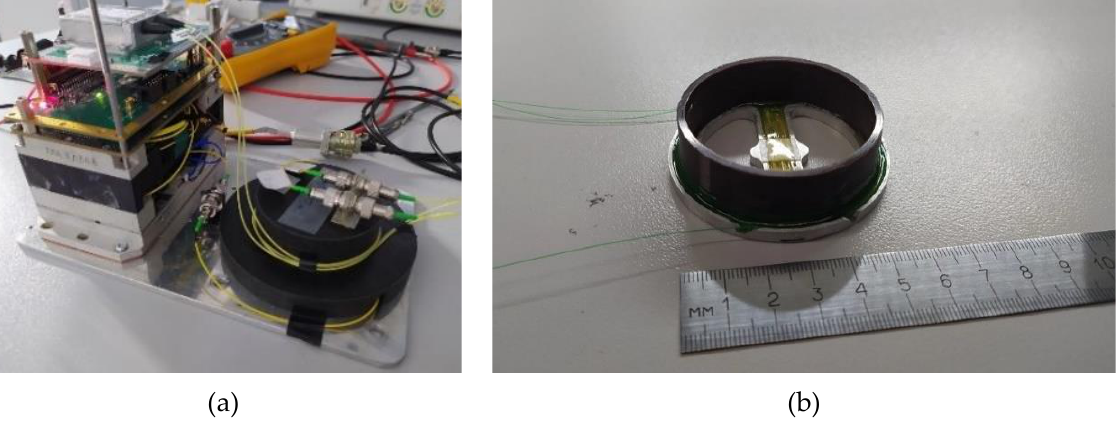
Figure 5. ( a ) Experimental setup, realizing the scheme of the resonant interferometric gyroscope with a 3 × 3 directional coupler and ( b ) a model of the sensing element of the optical resonant gyroscope with overall dimensions Ø60 × 25 mm.